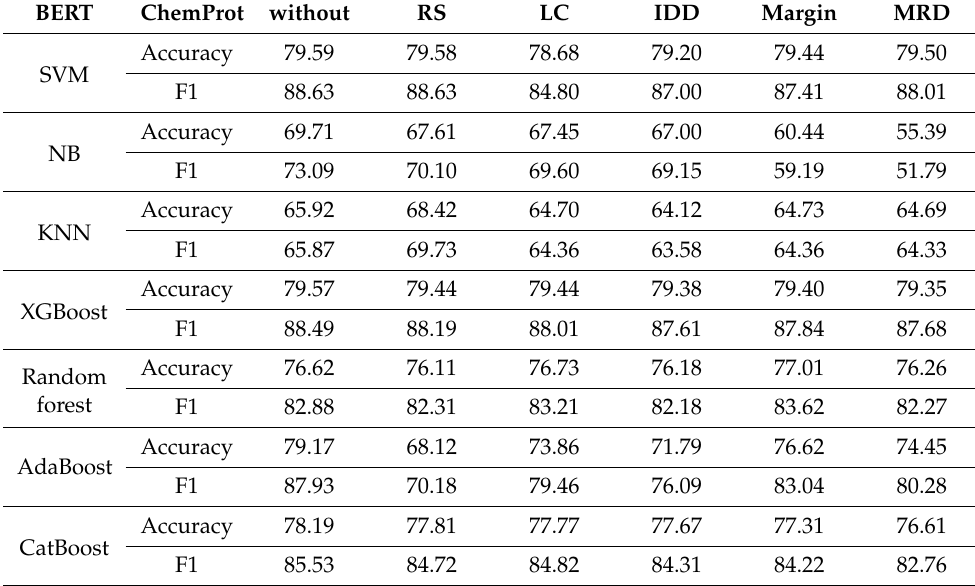
Table 10. Comparison of results with and without AL methods (BERT) for ChemProt dataset.